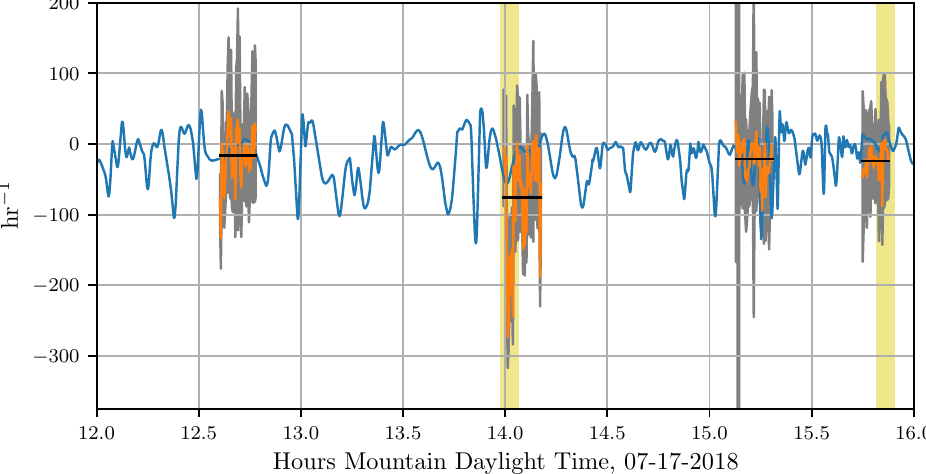
Figure 12. The attraction rate from WRF-LES predictions (blue) and the attraction rate as calculated from sensor measurements (orange) overlaid with flight average of the attraction rate (black). The uncertainty ranges for the attraction rate measurements are shown in gray. The attraction rate from the WRF-LES comes from the 10 m height level wind speed, while wind speed measurements used to calculate the attraction rate were performed by sensors at 15 m. Times of interest are highlighted with a yellow vertical line, corresponding to the predicted attraction rate fields shown in Figures 13 and 14, respectively.